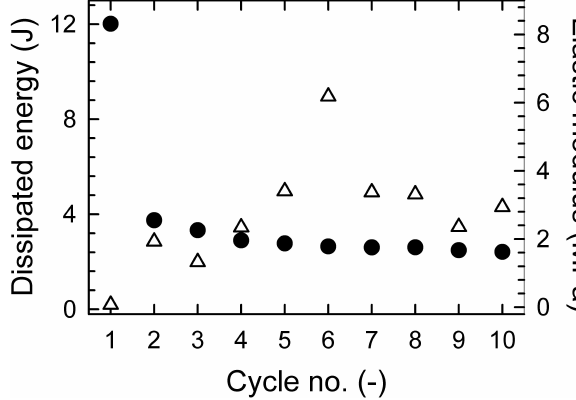
Figure 9: Results of the cyclic closed shell compression